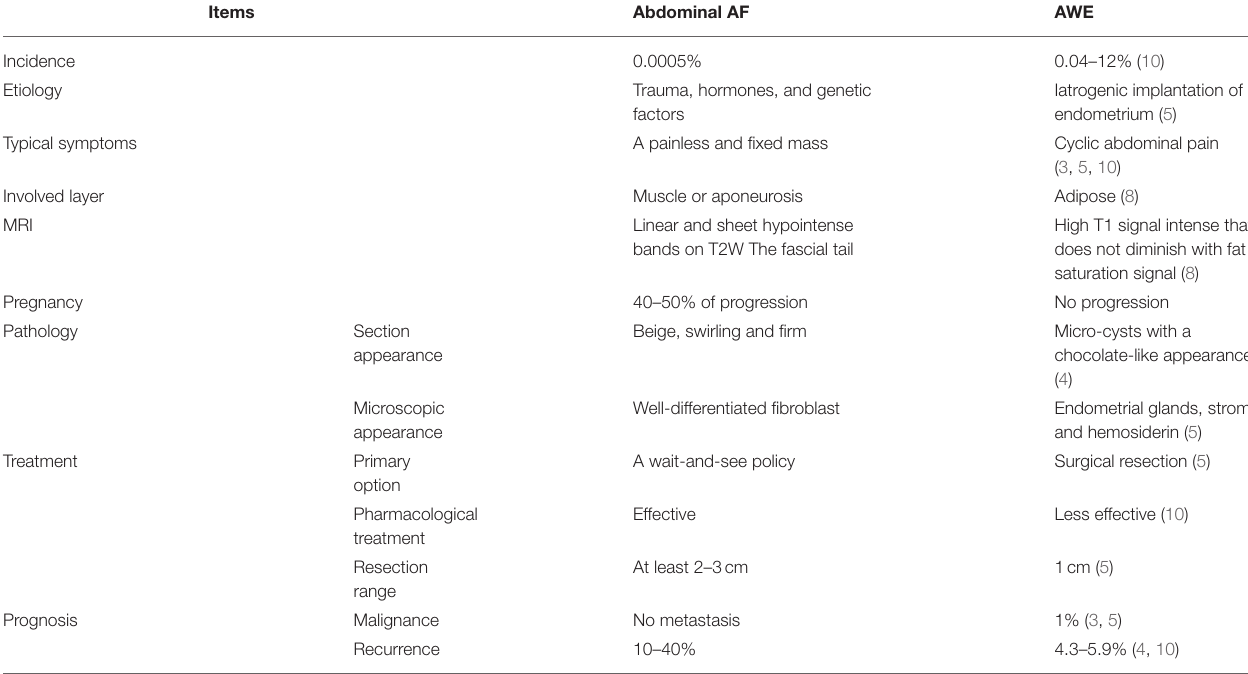
TABLE 1 | Differences of clinical features between abdominal AF and